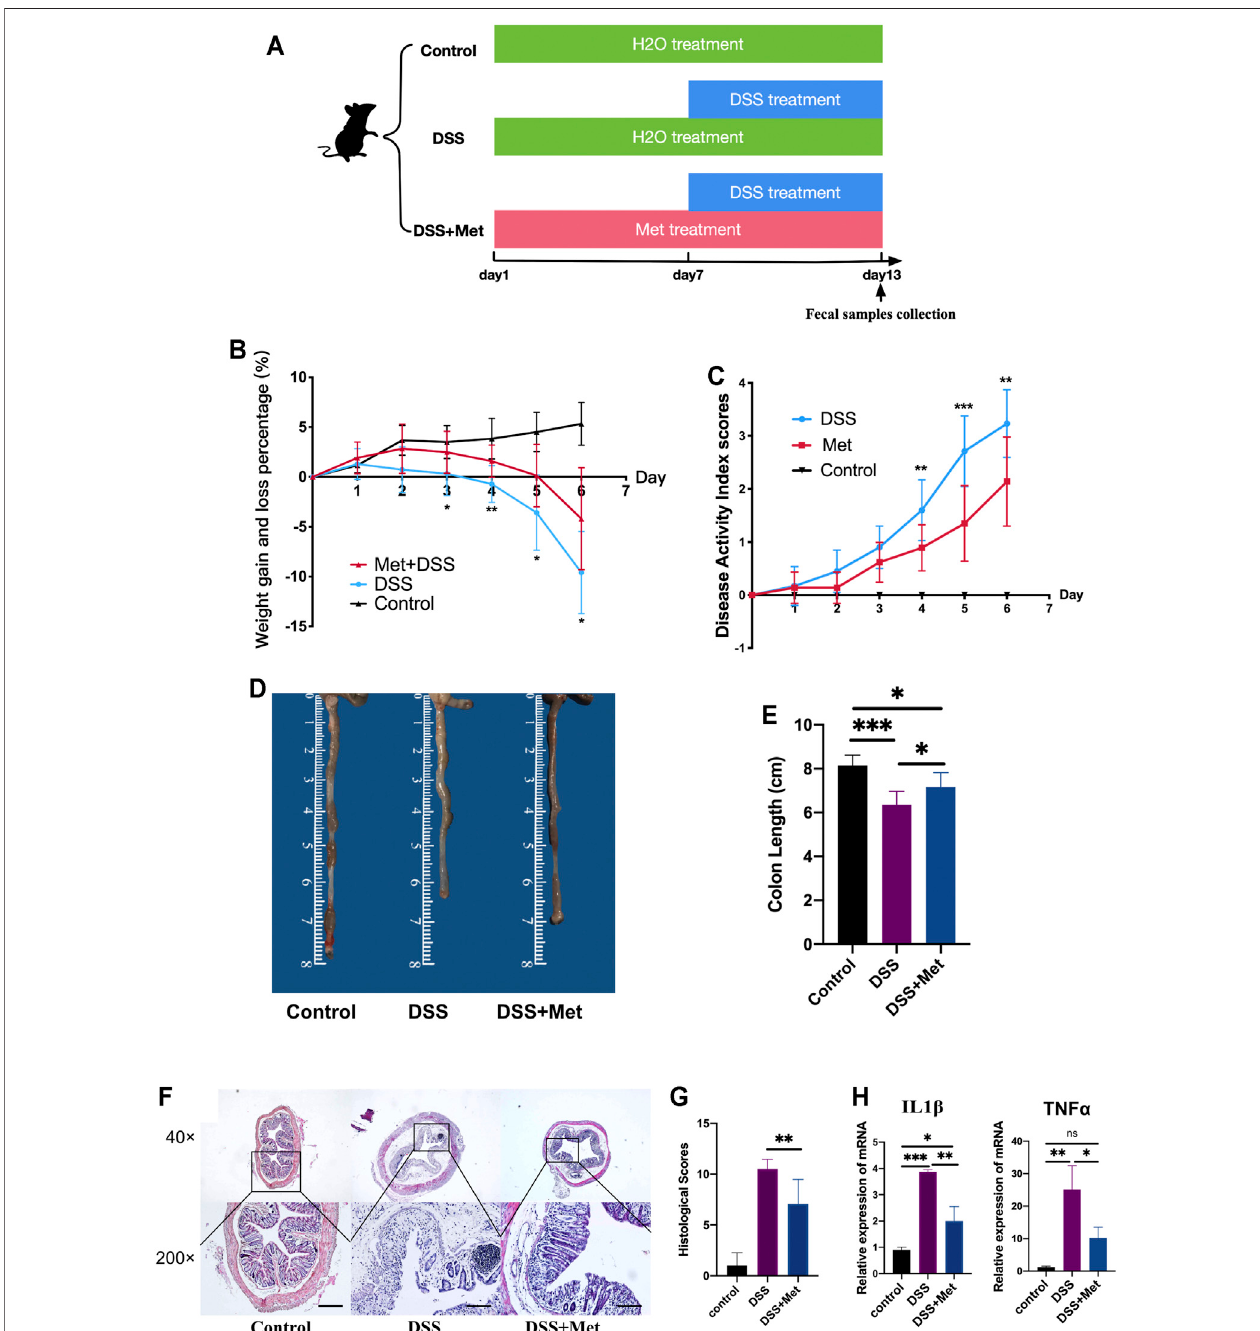
FIGURE1| Metforminalleviatesdextran sulfate sodium (DSS)-induced ulcerativecolitis(UC)inmice.Flowchartofanimaltreatment( n (cid:1) 6 – 10) (A) ,weight lossand gain ( n (cid:1) 6 – 10) (B) , disease activity index (DAI) scores ( n (cid:1) 6 – 10) (C) , representative pictures of the mouse colon ( n (cid:1) 6 – 10) (D) , colon length ( n (cid:1) 6 – 10) (E) , hematoxylin and eosin (HE) staining (scale bars, 400 μ m) ( n (cid:1) 6 – 10) (F) , and histological scores ( n (cid:1) 6 – 10) (G) . RT-qPCR assay of tumor necrosis factor- α (TNF- α ) and interleukin 1 β (IL1 β ) in colon tissue ( n (cid:1) 3) (H) and statistical comparison was made using an ANOVA test followed by Tukey-Kramer post-hoc tests. * p < 0.05, ** p < 0.01, *** p <